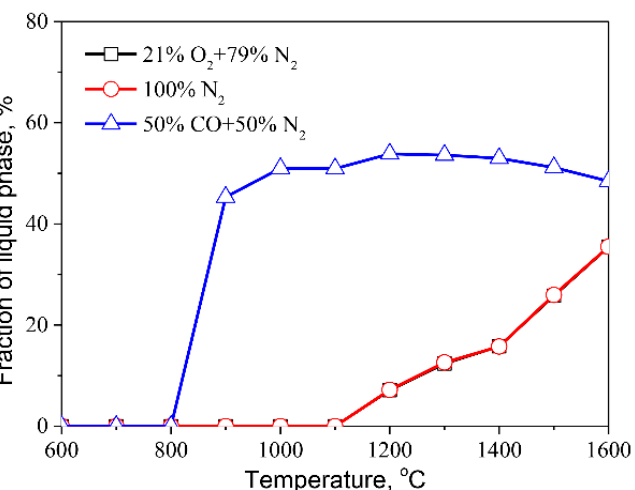
Figure 3. Liquid fraction in the MSWI ash as functions of atmospheres and temperatures.